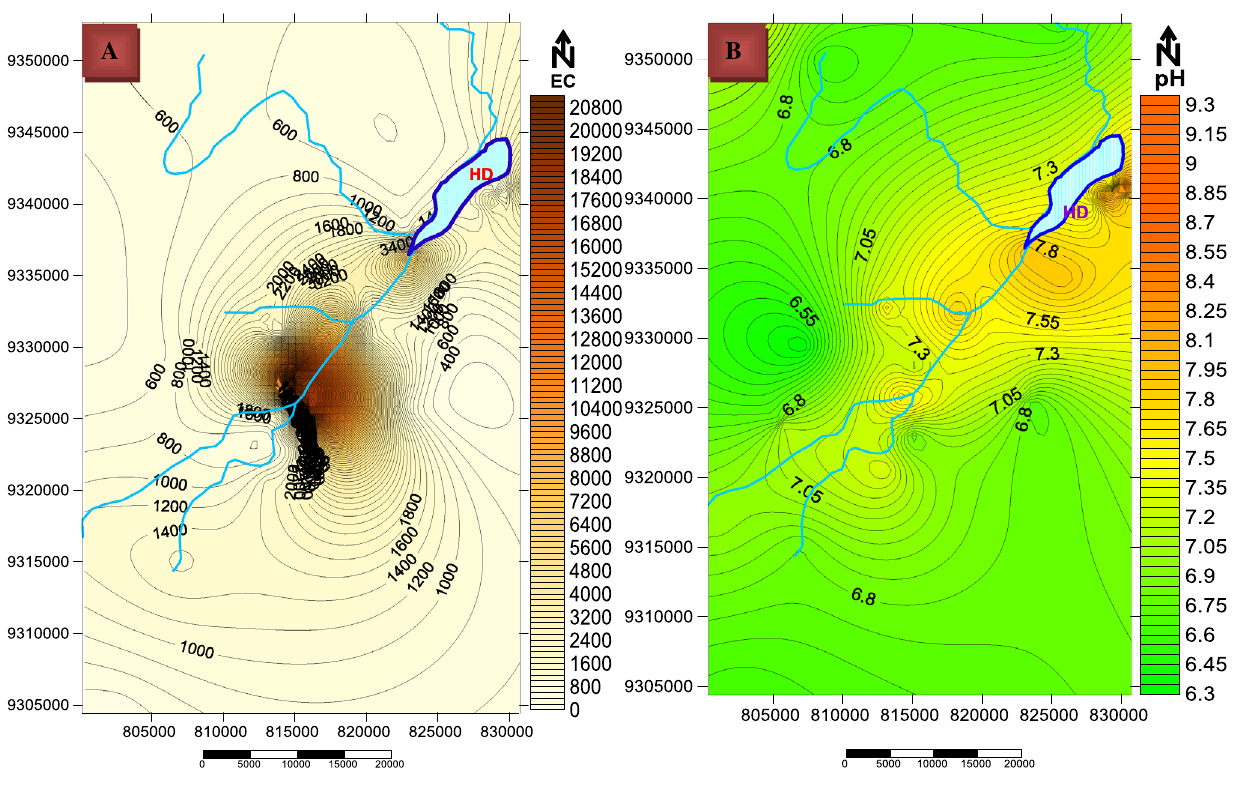
Fig. 2 a Spatial EC distribution, b Spatial pH distribution from the study